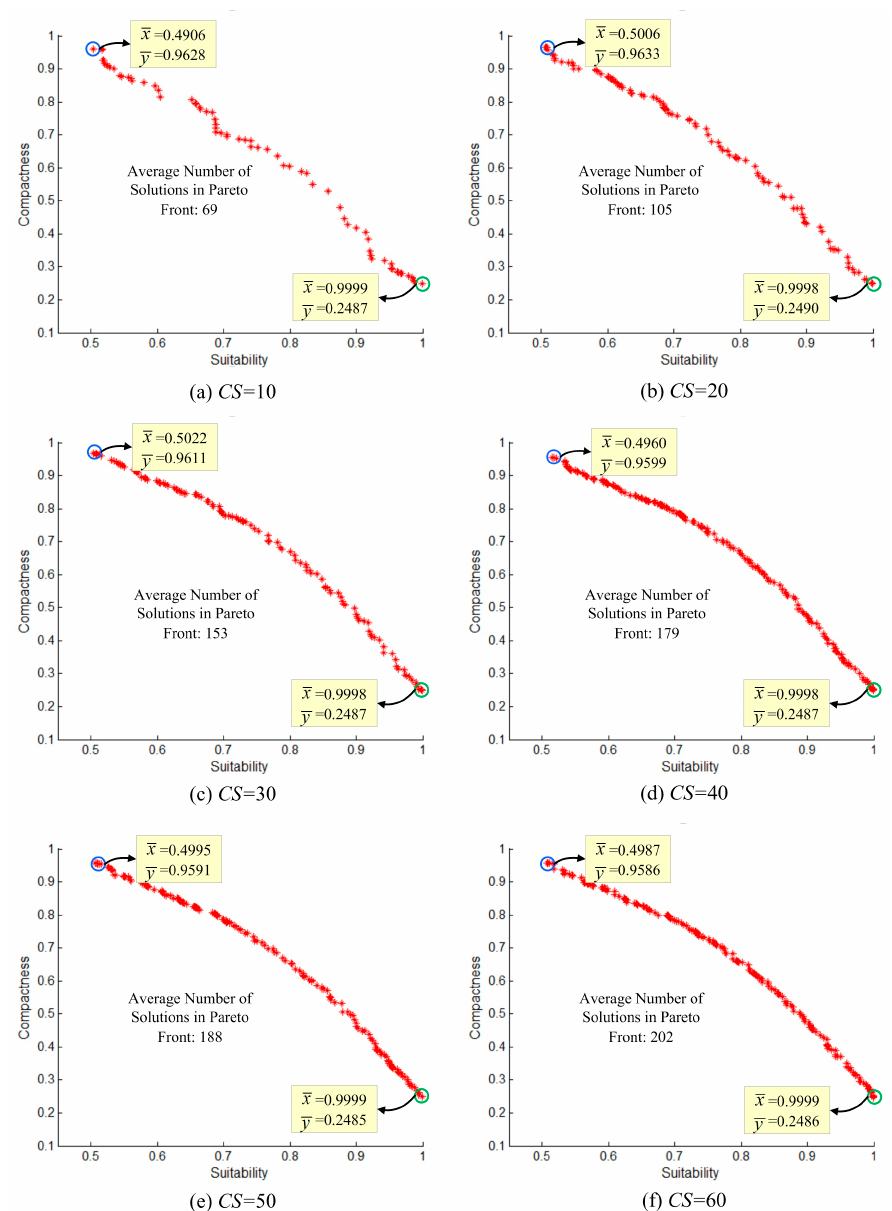
Figure 16. Results of ABC-MOLA with different CS values. The red dots are the solutions in the Pareto front, and x and y are the average values of suitability and compactness, respectively. ( a ) The Pareto front while CS = 10; ( b ) The Pareto front while CS = 20; ( c ) The Pareto front while CS = 30; ( d ) The Pareto front while CS = 40; ( e ) The Pareto front while CS = 50; ( f ) The Pareto front while CS =